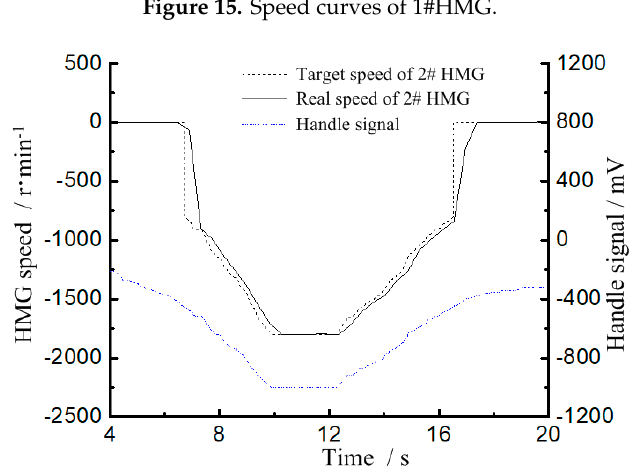
Figure 15. Speed curves of 1#HMG.